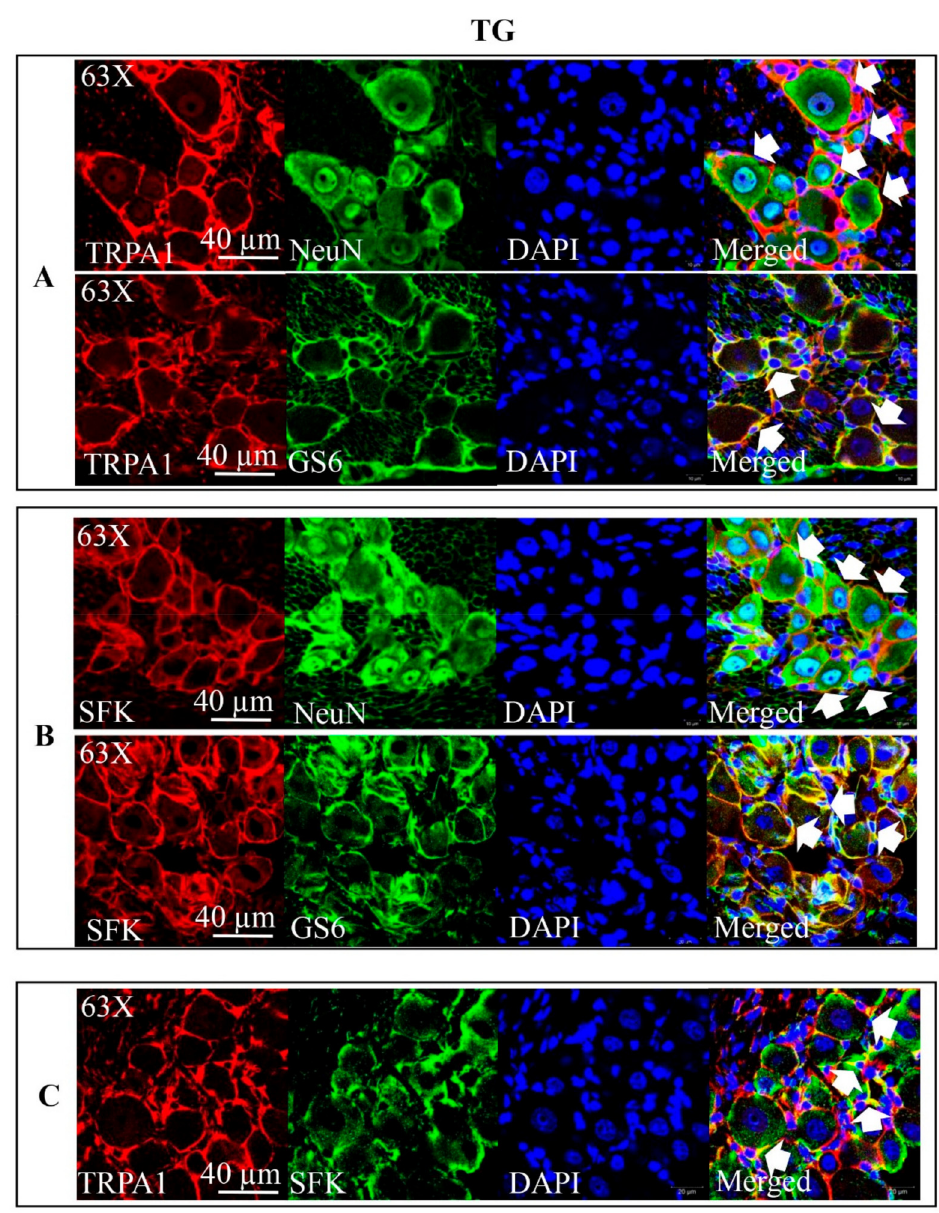
Figure 3. TRPA1 and SFKs were co-localized in mouse TG. ( A , B ) Representative images of expression of TRPA1 or SFKs in neurons and satellite glial cells of mouse TG. ( C ) Representative images of co- localization of TRPA1 and SFKs in mouse TG. Staining with DAPI indicated nucleus as shown in blue; staining with anti-TRPA1 antibody was shown in red; staining with anti-NeuN antibody indicated neurons and staining with anti-GS6 antibody indicated satellite glial cells as shown in green. Double immune-labeling with indicated antibodies showed expression of TRPA1 and SFKs in neurons and satellite glial cells of TG or co-expression of TRPA1 and SFKs in TG (white arrows, n = 3 per